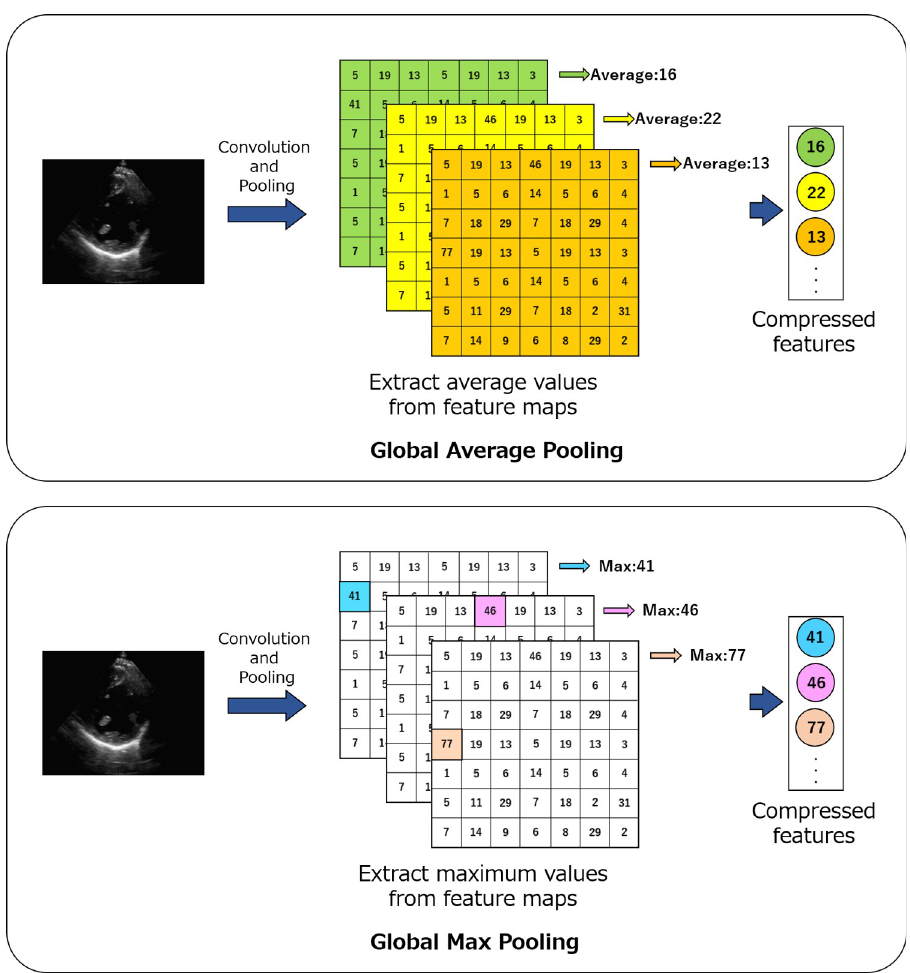
Fig 6. Simplified diagram of the global average pooling and global max pooling compression methods. Pooling is performed to extract the maximum or average values from the last feature map of the CNN.